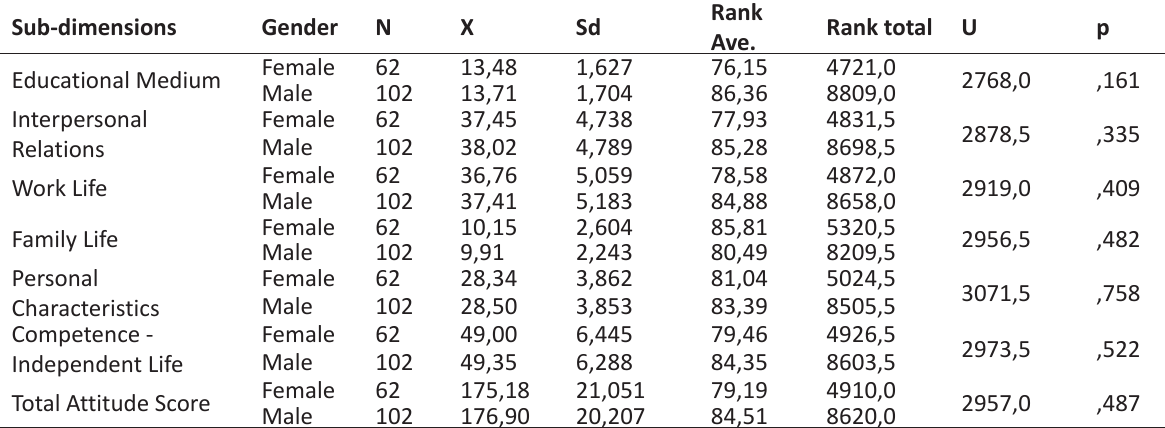
Table 3. Comparison of Attitude Levels of the Participants according to Gender Variable